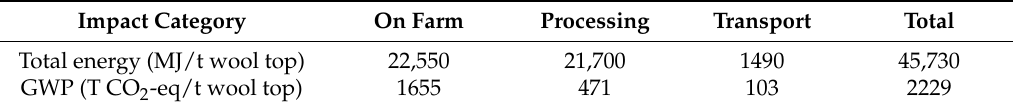
Table 2. Energy use and greenhouse gas emissions (GWP) for 1 tone merino wool top as reported by Barber and Pellow